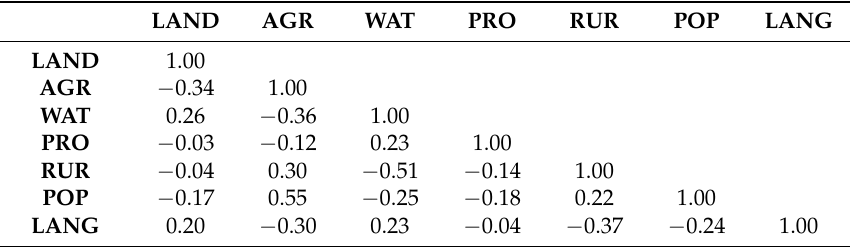
Table 5. Correlation among variables of the “suitable land” group.